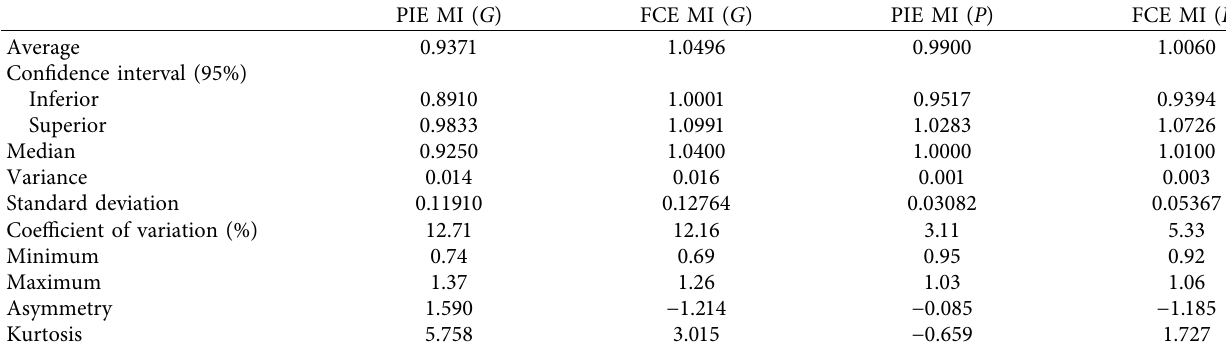
Table 8: Descriptive statistics of the Malmquist